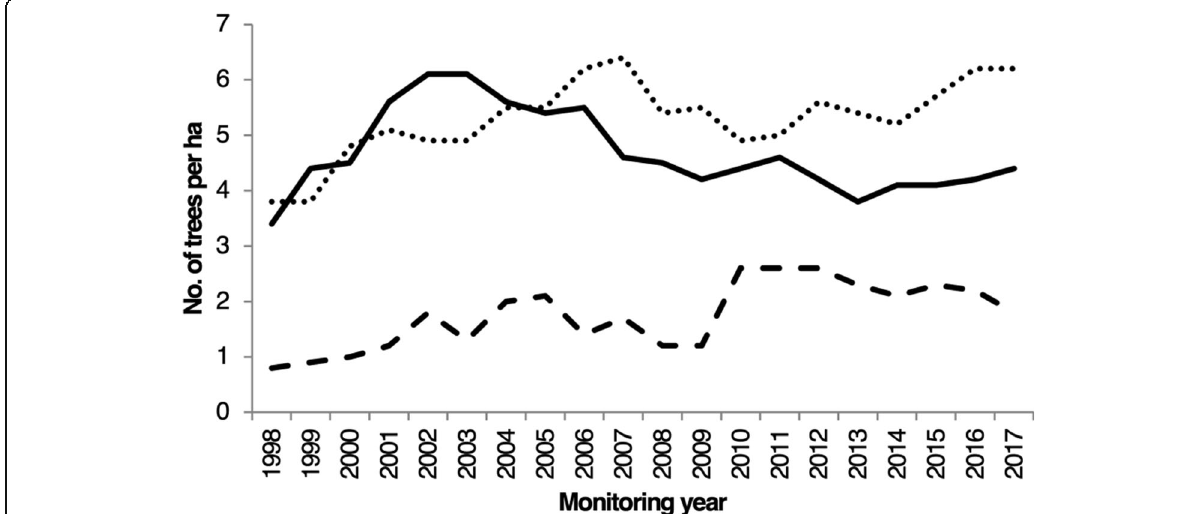
Fig. 4 Numbers of living large-diameter (DBH > 20 cm, solid line) and small-diameter (10 – 20 cm, dotted line) retention trees and dead trees (DBH > 10 cm or DBH > 20 cm from 2005 onwards, dashed line) (no. of trees per hectare) in 1998 – 2017 in clearcutting areas of private forests (data: Forestry Centre Tapio 2013, Finnish Forest Centre 2019). The numbers of living large-diameter retention trees have decreased during the monitoring years from the level of the early years of PEFC certification (early 2000s) (Kendall ’ s rank correlation coefficient r K = − 0.37, p = 0.026), and the numbers of living small-diameter retention trees ( r K = 0.52, p = 0.002) and dead retention trees ( r K = 0.51, p = 0.002) have increased during the monitoring years. The pooled numbers of all living retention trees ( r K = − 0.01, p = 1.0) have remained the same during